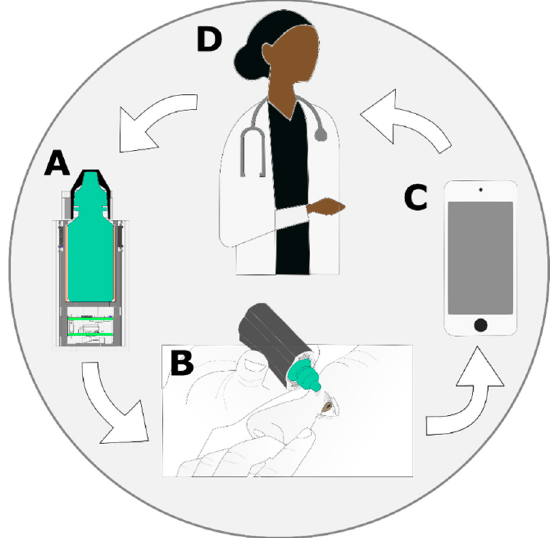
Figure 1. Overview of information flow in the system. ( A ) The prescription bottle is placed in the sleeve with the embedded sensors and electronics. ( B ) Data from the sensors detect use and monitor fluid level. ( C ) Data and usage information are transmitted from the system to a smart phone or another Bluetooth connected device. ( D ) Healthcare providers use this information to inform clinical decisions.